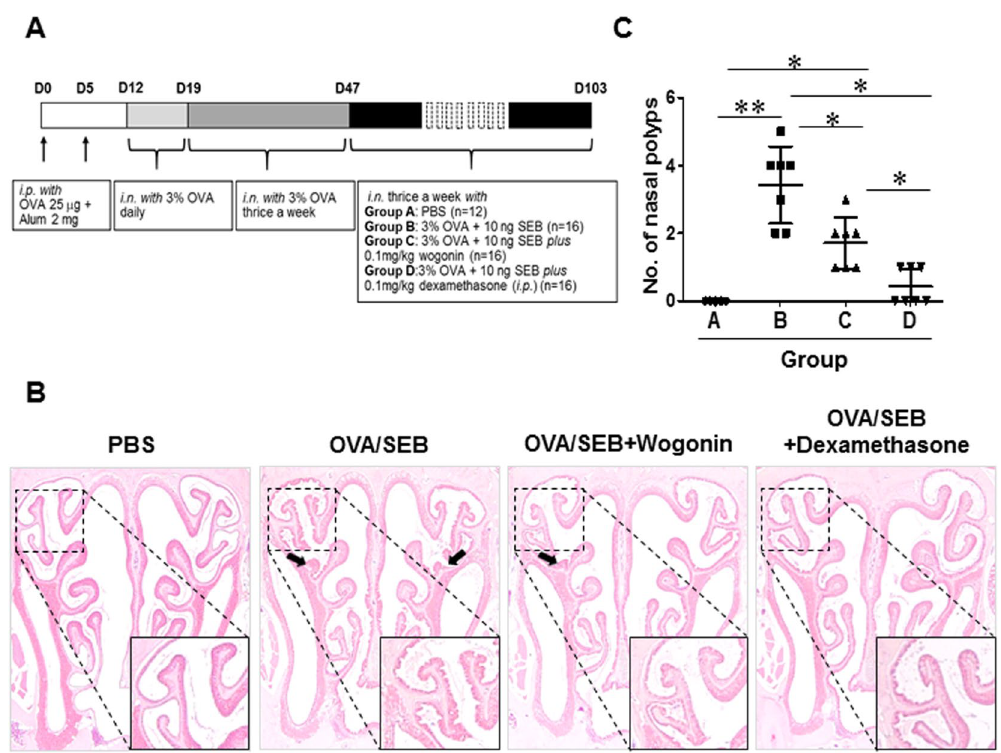
Figure 5. Nasal polyp burden is reduced in the wogonin-treated group. ( A ) Protocol for the development of chronic eosinophilic rhinosinusitis with nasal polyps in mice. Alum, Aluminum hydroxide; i.p., intraperitoneal injection; i.n., intranasal instillation. ( B ) and ( C ) Photographs of representative nasal polypoid lesions (arrows) stained with hematoxylin and eosin (original magnification × 1.25). Nasal polypoid lesions were detected in Groups B, C, and D. Numbers of nasal polyp-like lesions were expressed as the total number per coronal section. The numbers of polyp-like lesions were reduced in Groups C and D compared with that in Group B. The black box indicates the magnified area. Data are expressed as the means ± SD. * P < 0.05, ** P < 0.01. Mann- Whitney U test. Scale bar = 20 μ